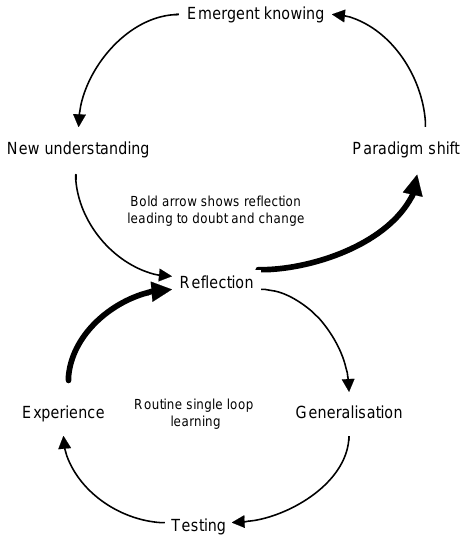
Figure 1. Double loop learning (after Argyris & Schön, 1978: Figure by Kate Lonsdale in Forrester et